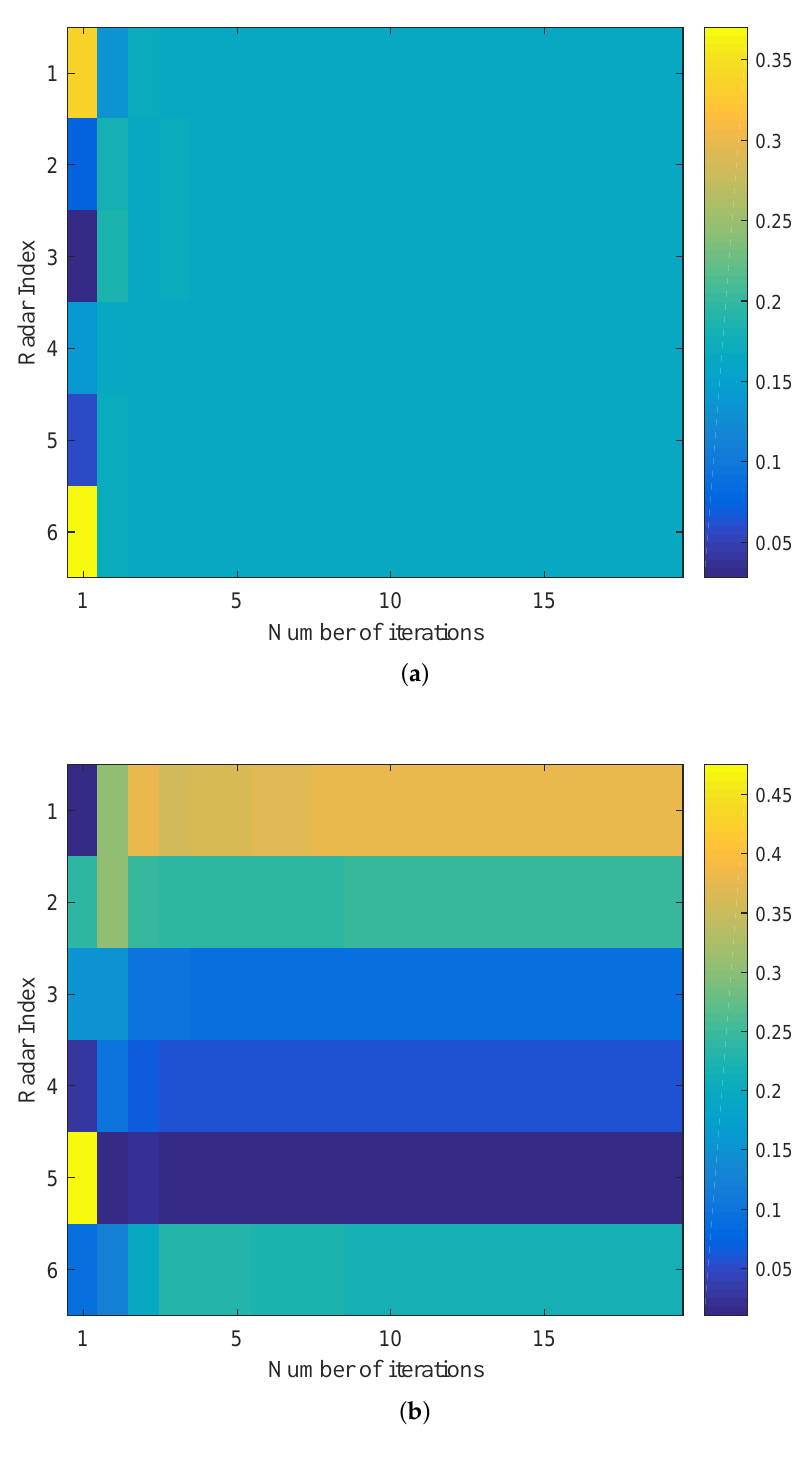
Figure 4. Convergence behavior for the transmit power allocation in the first case: ( a ) Target position is [ 0,0 ] km; ( b ) Target position is [ − 30, − 40 ]